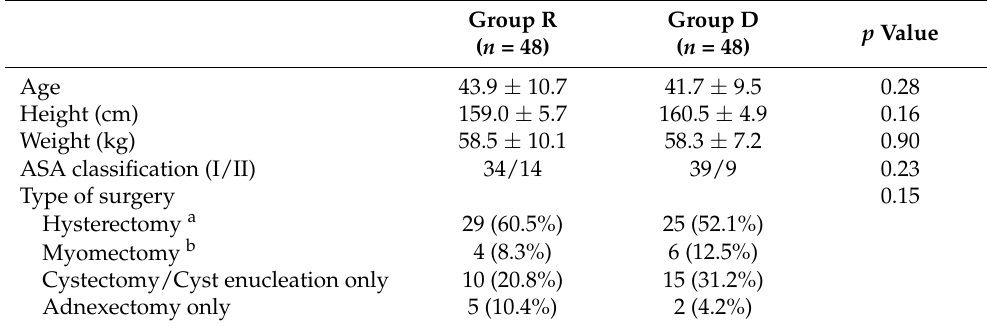
Table 1. Characteristics of the patients at baseline.